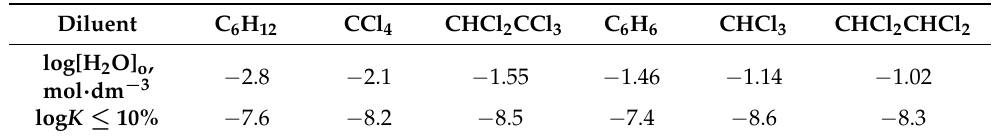
Table 9. Values of water solubility and the extraction constant for Eu 3+ − TTA in different diluents [72]. ©1983